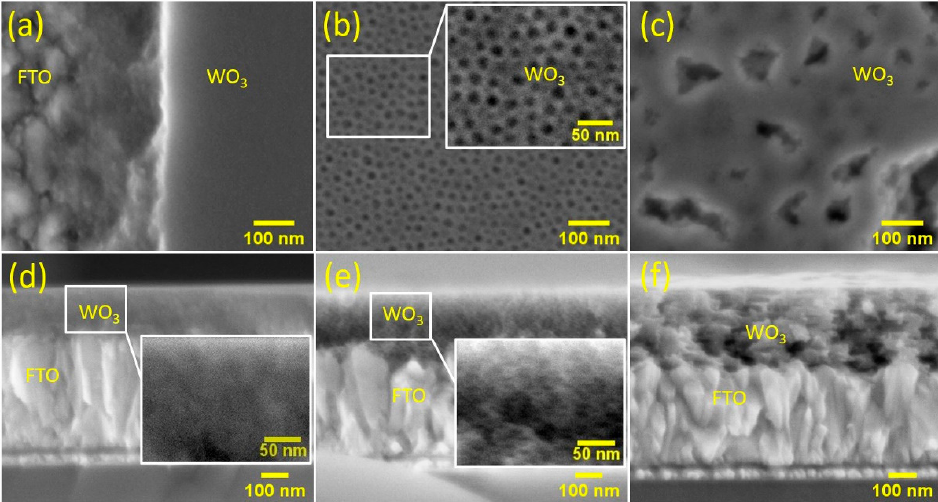
Figure 1. Top view ( a – c ) and cross-section ( d – f ) of the WO 3| µp600 ( a , d ), WO 3| mp ( b , e ), and WO 3| µmp ( c , f ) thin films on FTO. The left part of the film in ( a ) was scratched off to provide a comparison to the bare substrate.